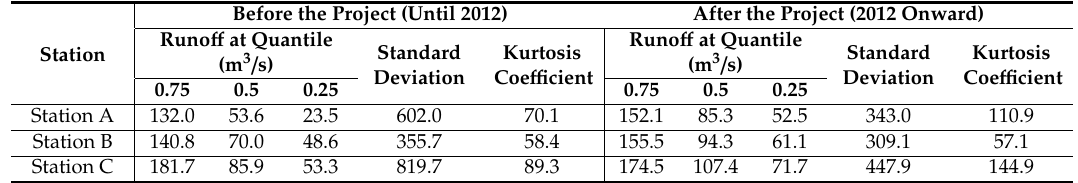
Figure 1. The target stations of the study in the main stream of the Nakdong River; red inverted triangles indicate water level stations, and gray blocks indicate multi-purpose weirs which were completed in 2012 by the Four Major Rivers Restoration Project [43]. Table 1. The general flow condition at target stations before and after the Four Major Rivers Restoration Project.